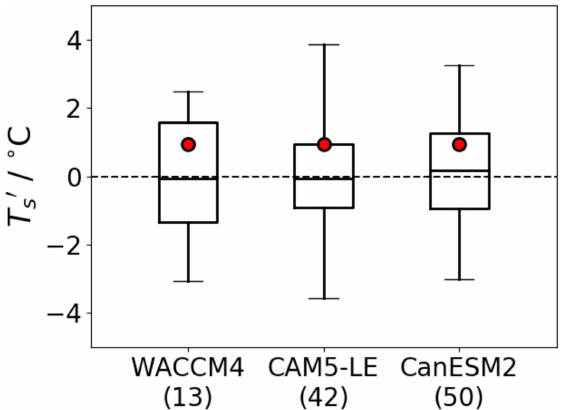
Figure 4. Box-and-whisker plots of simulated surface temperature anomaly ( ◦ C) over Eurasia (40–70 ◦ N, 0–150 ◦ W) in the first post- Pinatubo winter (1991–1992) relative to the reference period (1985– 1990). The horizontal line inside each box denotes the ensemble mean; the lower and upper limits of each box denote the 25th and 75th percentile values, respectively; the whiskers span the full range of the ensemble members. For comparison, the red circles denote the value calculated from the ERA-Interim